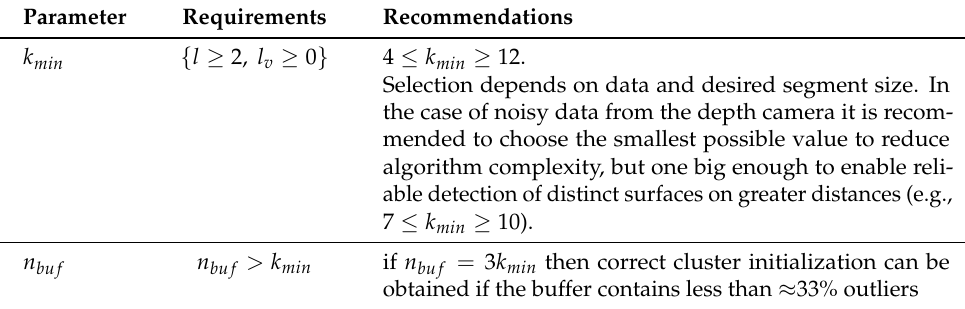
Table 1. Parameter selection